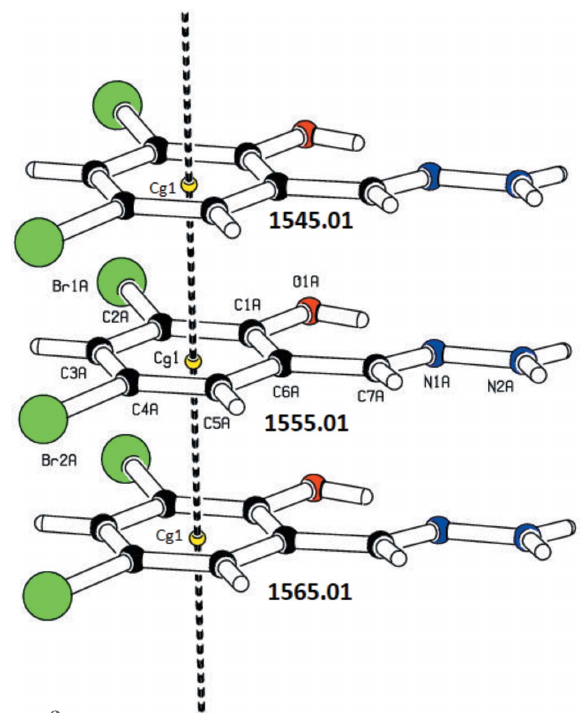
Figure 3 (cid:2) – (cid:2) contacts for the title compound (symmetry codes: 1545.01 = x , y (cid:4) 1, z ; 1565.01 = x , y + 1, z